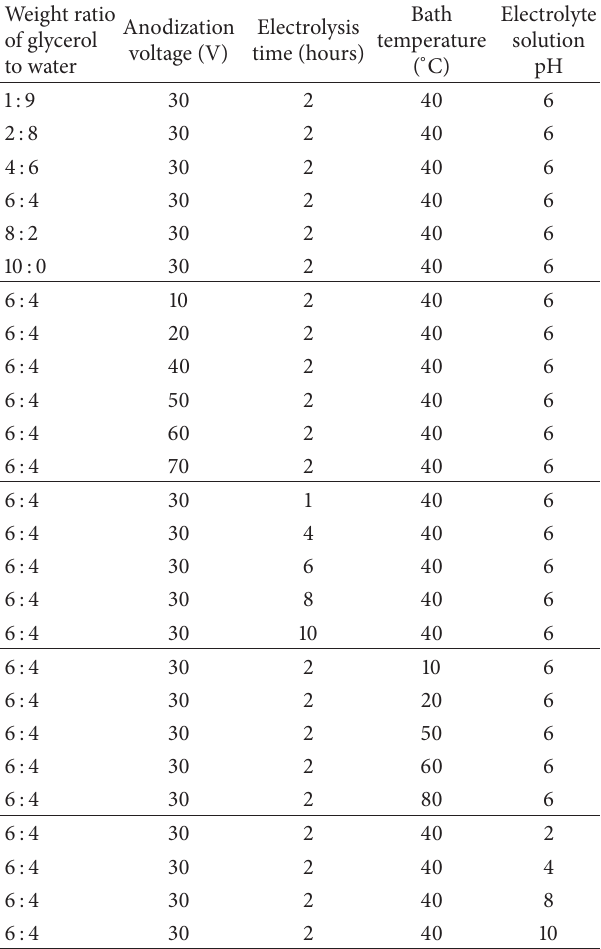
Table 1: Experimental design matrix for preparation of